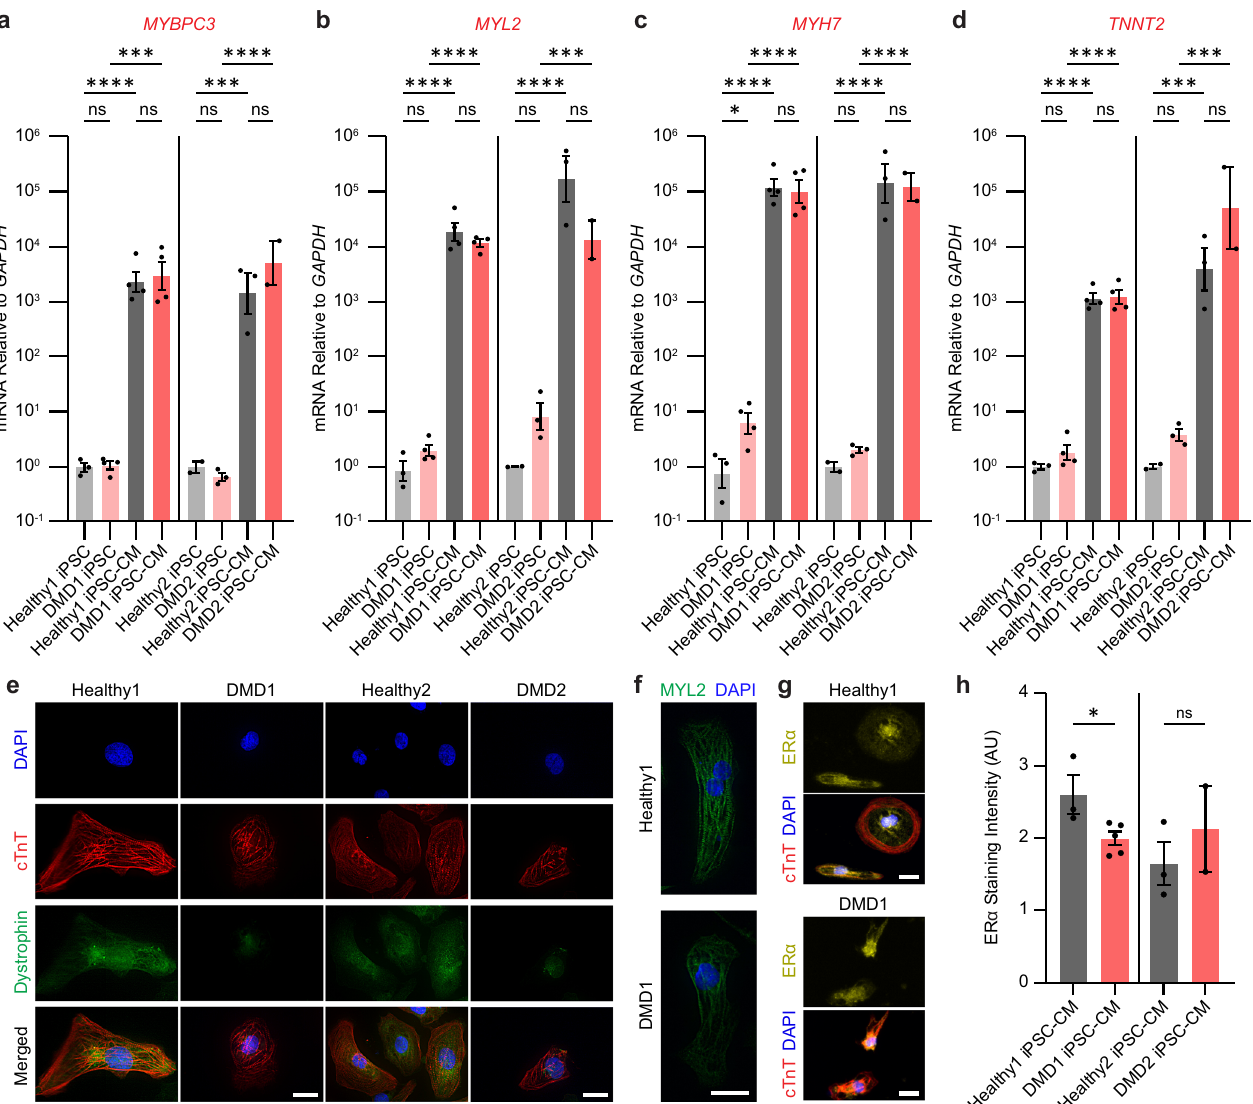
Fig. 2 Characterization of iPSC-CMs. a – d RT-qPCR results from iPSCs and iPSC-CMs of cardiac lineage markers, MYBPC3 , MYL2 , MYH7 , and TNNT2 . Data represent mean ± SEM. Statistical signi fi cance determined by one-way ANOVA and Tukey test for post hoc comparison. * P < 0.05, ** P < 0.01, *** P < 0.001, **** P < 0.0001, ns (nonsigni fi cant). n = 2 – 4 biological replicates. e 3D deconvoluted micrographs of iPSC-CMs stained for DAPI (blue), cTnT (red), and dystrophin (green) taken at ×63 magni fi cation. Healthy1 and DMD1 iPSC-CMs were stained with MANEX1A. Healthy2 and DMD2 iPSC-CMs were stained with ab15277. Detection of the short Dp71 isoform of dystrophin likely accounts for the nuclear staining. f 3D deconvoluted micrographs of iPSC-CMs stained with DAPI (blue) and MYL2 (green) taken at ×63 magni fi cation. g Micrograph of iPSC-CMs stained with ER α (yellow), cTnT (red), and DAPI (blue) immediately after treatment with 4-hydroxytamoxifen taken at ×40 magni fi cation. Scale bars represent 20 μ m. h Intensity of ER α staining over cell area in arbitrary units. Data represent mean ± SEM. Statistical signi fi cance determined by unpaired t test. * P < 0.05, ns (nonsigni fi cant). n = 2 – 5 biological replicates. N = 2818 – 9996